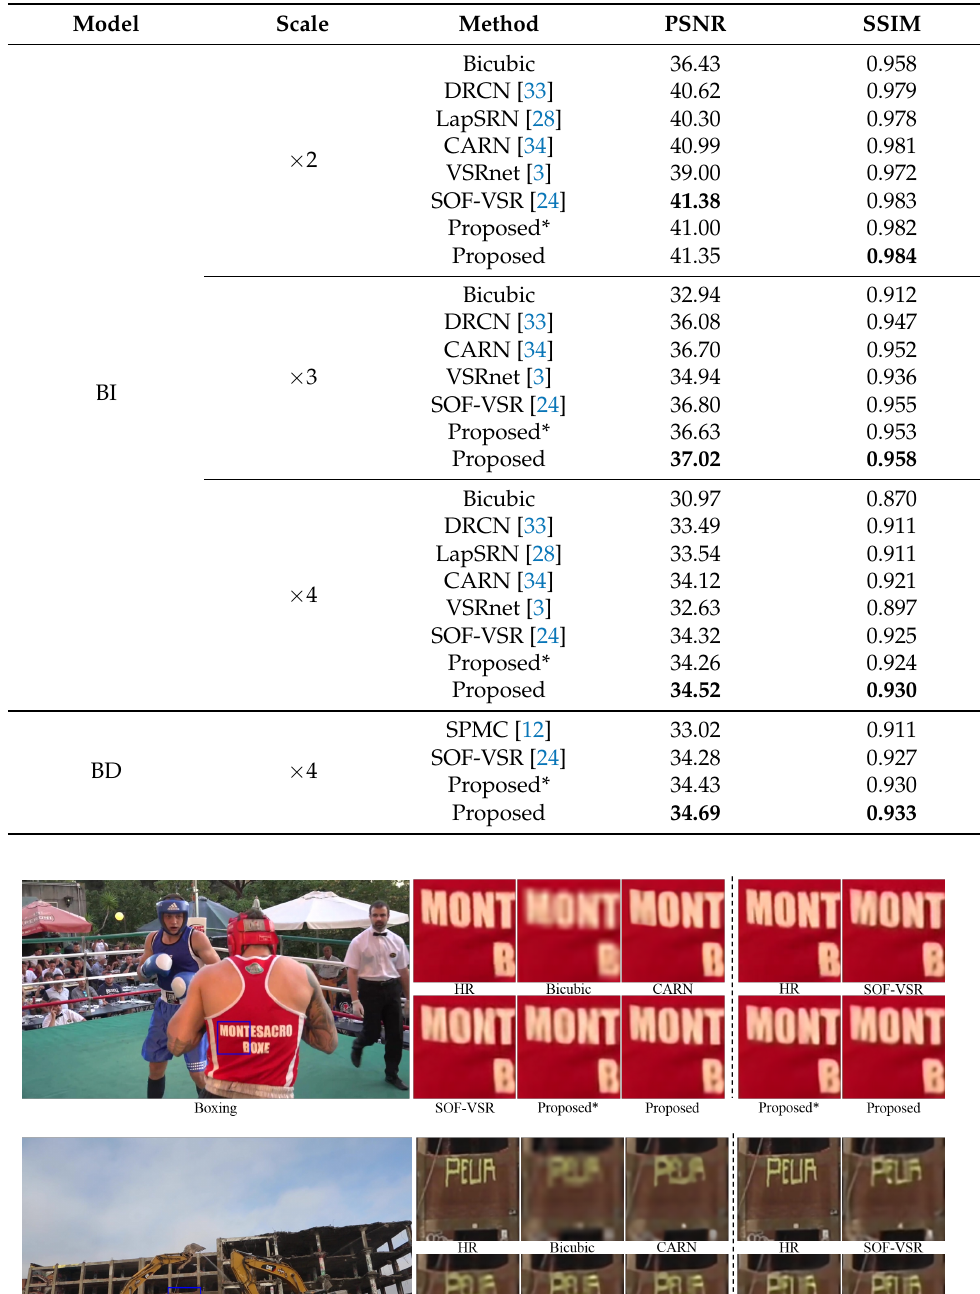
Table 5. The reconstruction results of the DAVIS-10 dataset at different reconstruction scales. The method marked with * only used non-local module, and the best results are indicated in boldface.